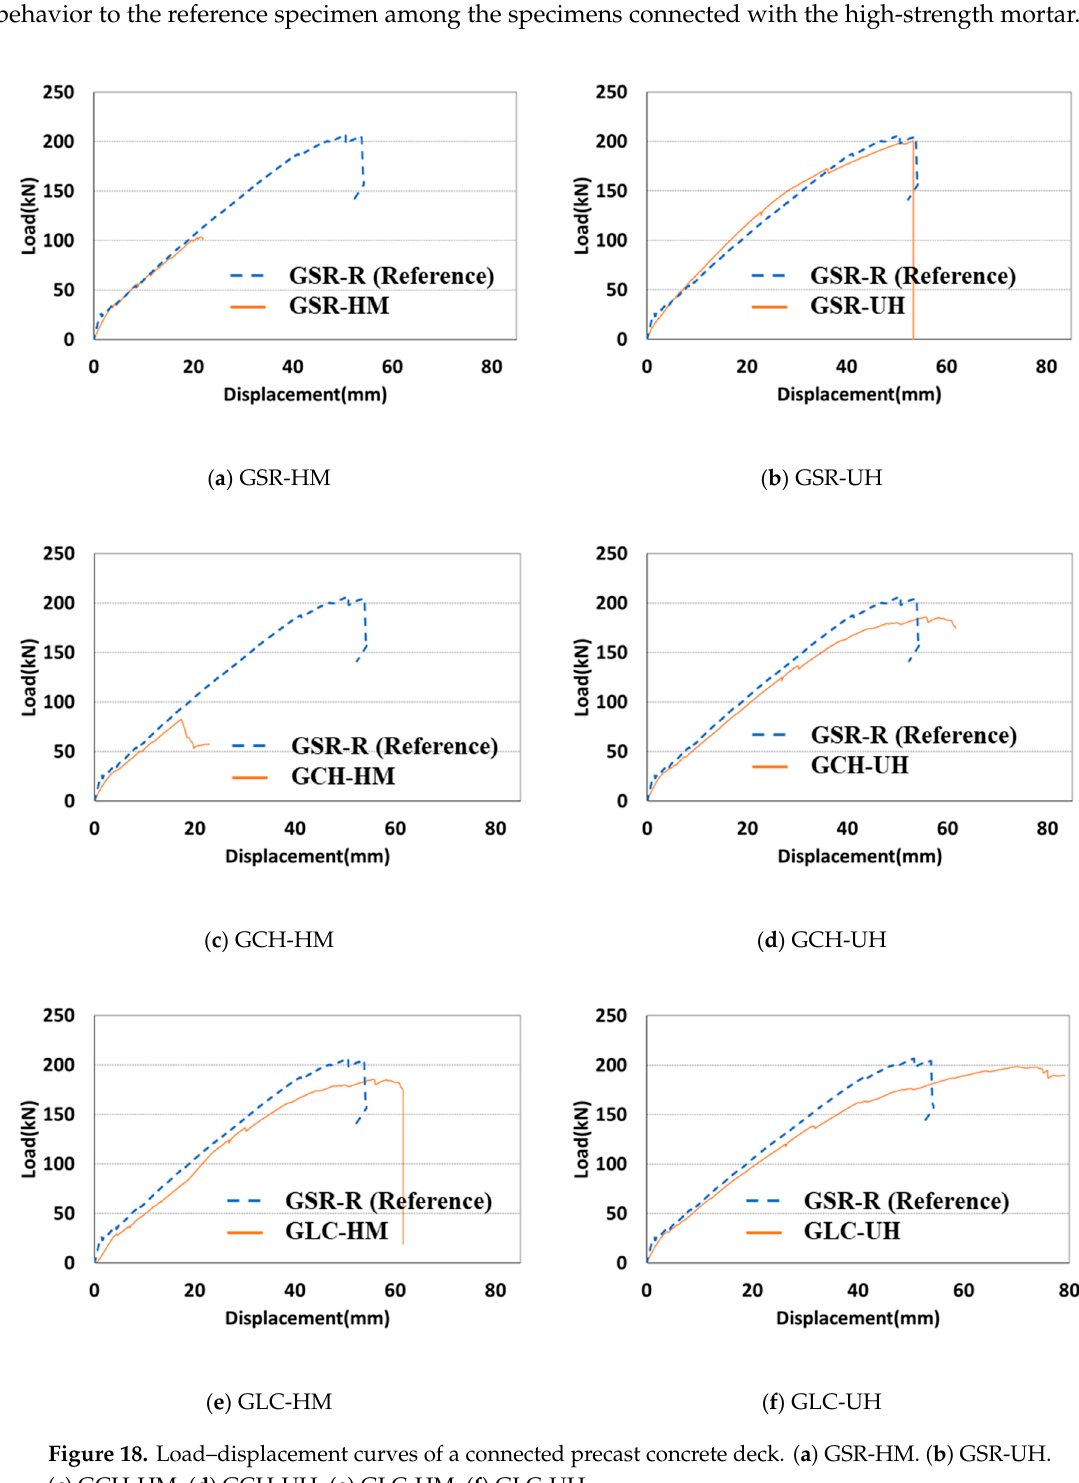
Figure 18. Load–displacement curves of a connected precast concrete deck. ( a ) GSR-HM. ( b ) GSR-UH. ( c ) GCH-HM. ( d ) GCH-UH. ( e ) GLC-HM. ( f ) GLC-UH